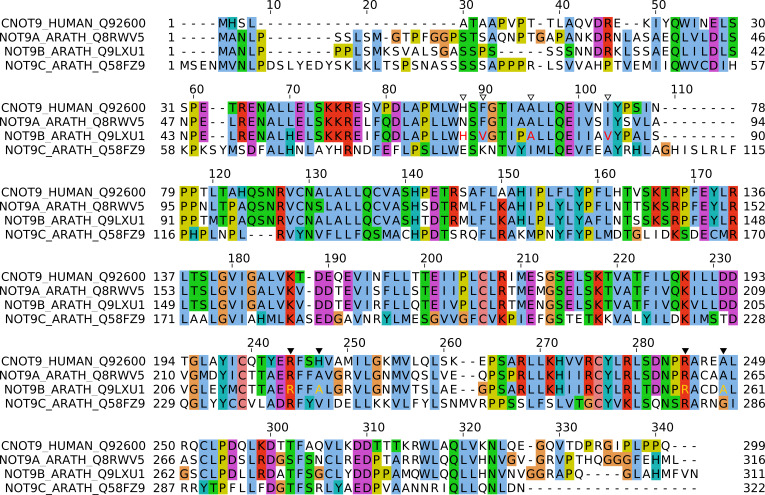
Sequence alignment for human CNOT9 and Arabidopsis NOT9 proteins.Sequences were retrieved from UniProt and aligned in JalView using MAFFT with default settings (UniProt Consortium, 2019; Katoh and Standley, 2013; Waterhouse et al., 2009). Open and closed triangles above the sequence alignment indicate residues mutated in NOT9B ΔPNB (red) and NOT9B ΔGWB (orange), respectively. UniProt sequence identifiers are included in the sequence names.